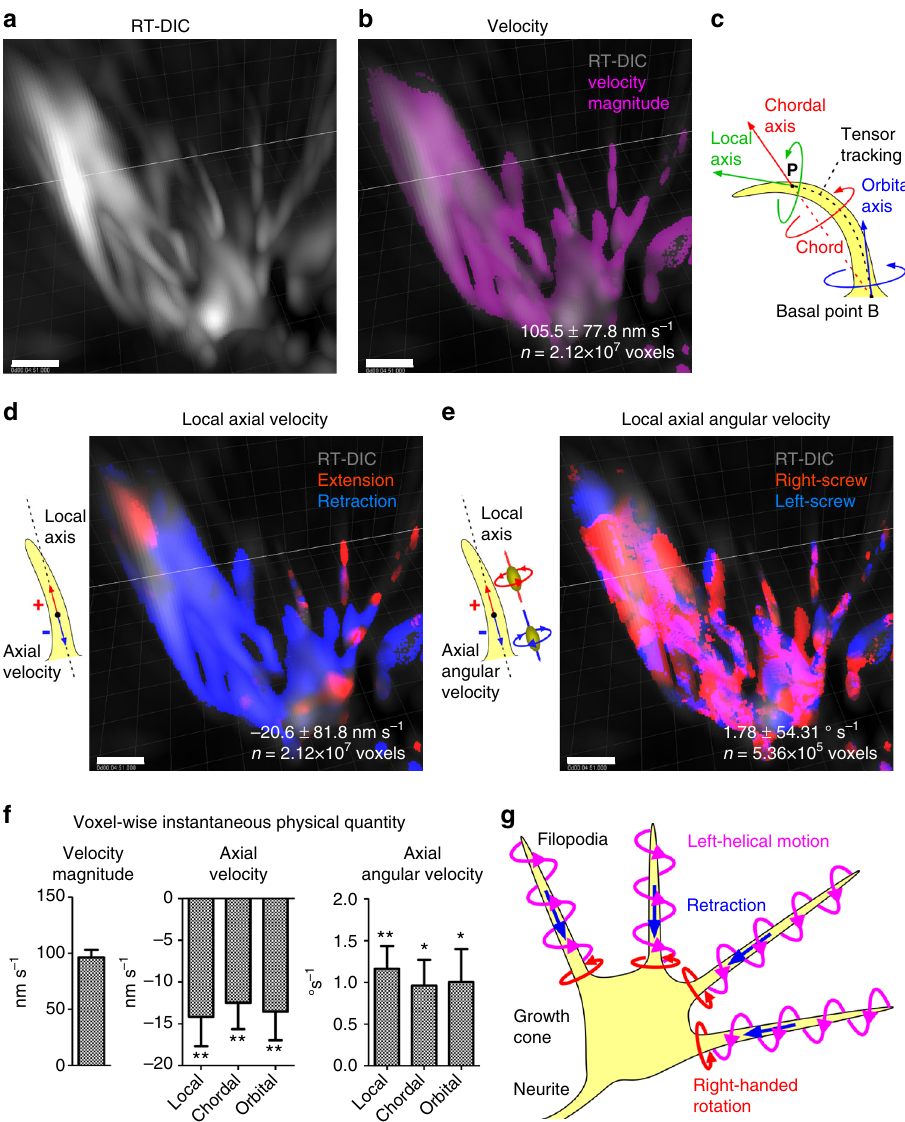
Fig. 4 Kinematic analysis of growth cone motility. a RT-DIC intensity image from oblique view. Growth cone from cell #2. b Distribution of velocity magnitude (magenta) overlaid on the RT-DIC intensity (gray). c De fi nition of the local, chordal and orbital axes at the point of interest P. d Distribution of axial velocity along the local axis. Positive (red) and negative (blue) values represent extension and retraction, respectively. e Distribution of axial angular velocity along the local axis. Positive (red) and negative (blue) values represent right-screw and left-screw rotation, respectively. The values in b , d , and e represent the mean ± s.d. for all voxels in all frames in the images of this growth cone. Their histograms are shown in Supplementary Fig. 6. All of the individual data for eight growth cones are shown in Supplementary Tables 2, 3. f Summary of voxel-wise instantaneous physical quantities. The values represent mean ± s.e.m. of the means for individual cells ( n = 8). * P < 0.05, ** P < 0.01. One sample t -test for the null hypothesis that the mean is equal to zero. g Chiral helical motility of growth cone fi lopodia revealed by the kinematic analysis. Scale bars, 1 μ